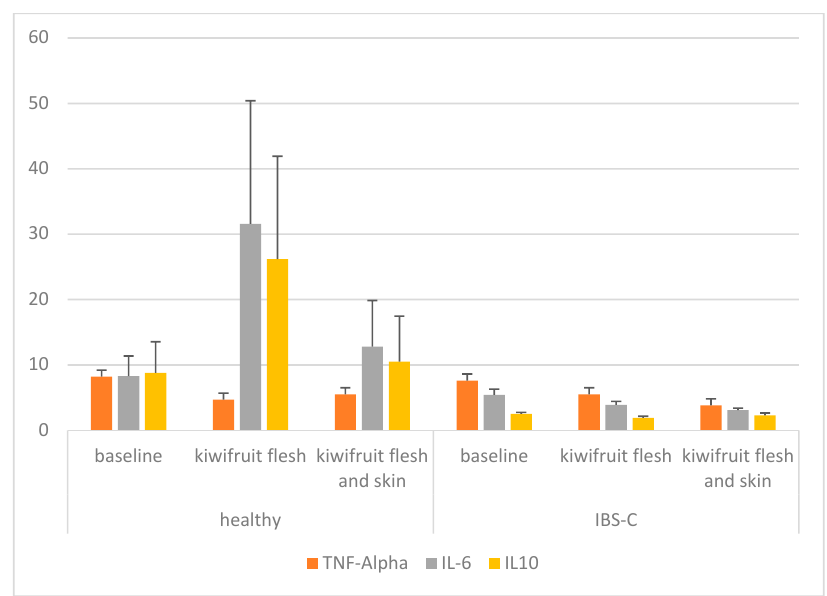
Figure 2. Bar graph of blood cytokine concentrations (pg/mL) of the participants consuming SunGold kiwifruit with and without skin, grouped into healthy individuals and those with IBS-C.